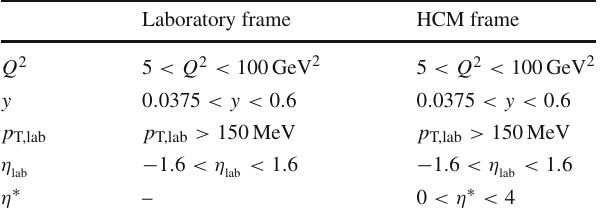
Table 1 Summary of the fiducial kinematic phase space used in this analysis Laboratory